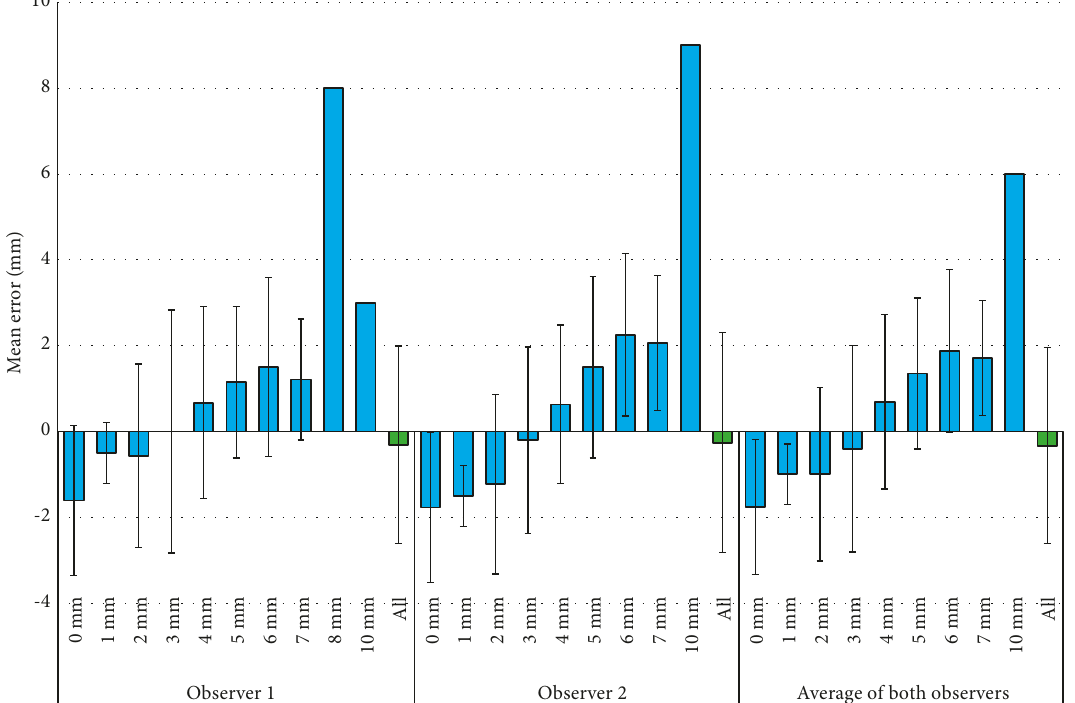
Figure 1: Mean (SD) of the errors of the radiograph examiners’ radiographic root resorption estimates (mm) in the case of each of the actual resorption extents (mm). The errors are computed as the actual resorption extent minus the radiographic resorption estimate; therefore, negative and positive errors, respectively, point to elongated (overestimated) and shortened (underestimated) radiographic root resorption estimates.